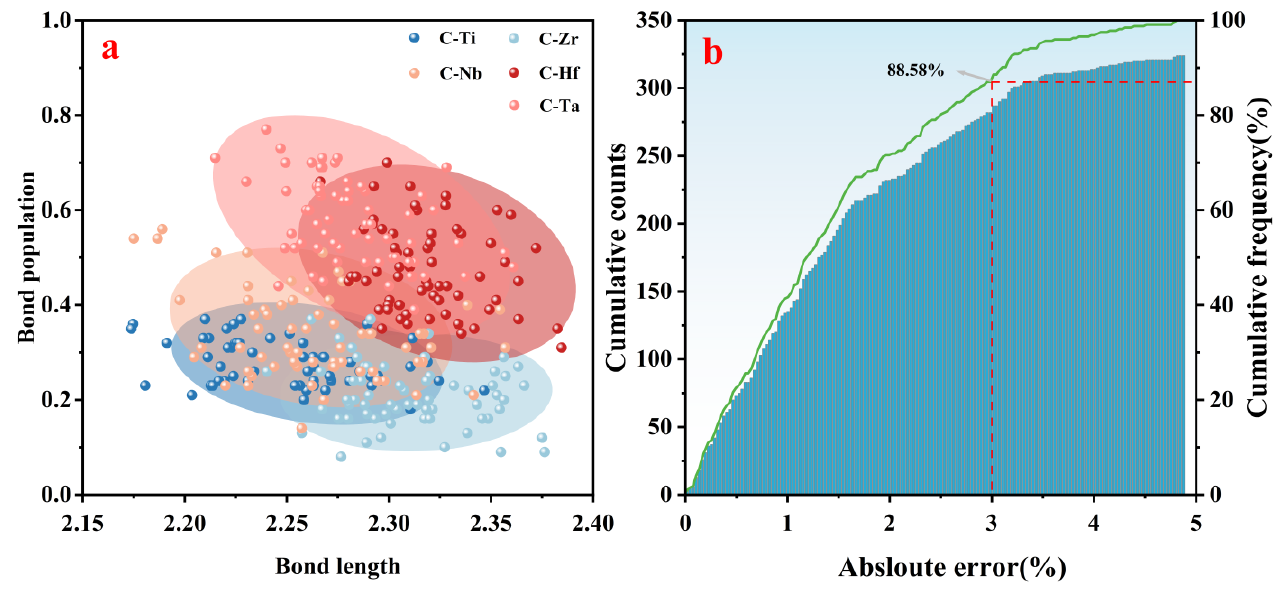
Figure 6. ( a ) The bond population (BP)–bond length (BL) of each bond (the dashed line represents the bond length in binary carbides); ( b ) the absolute error (%) between M-C in high-entropy carbide and TaC in binary carbide.